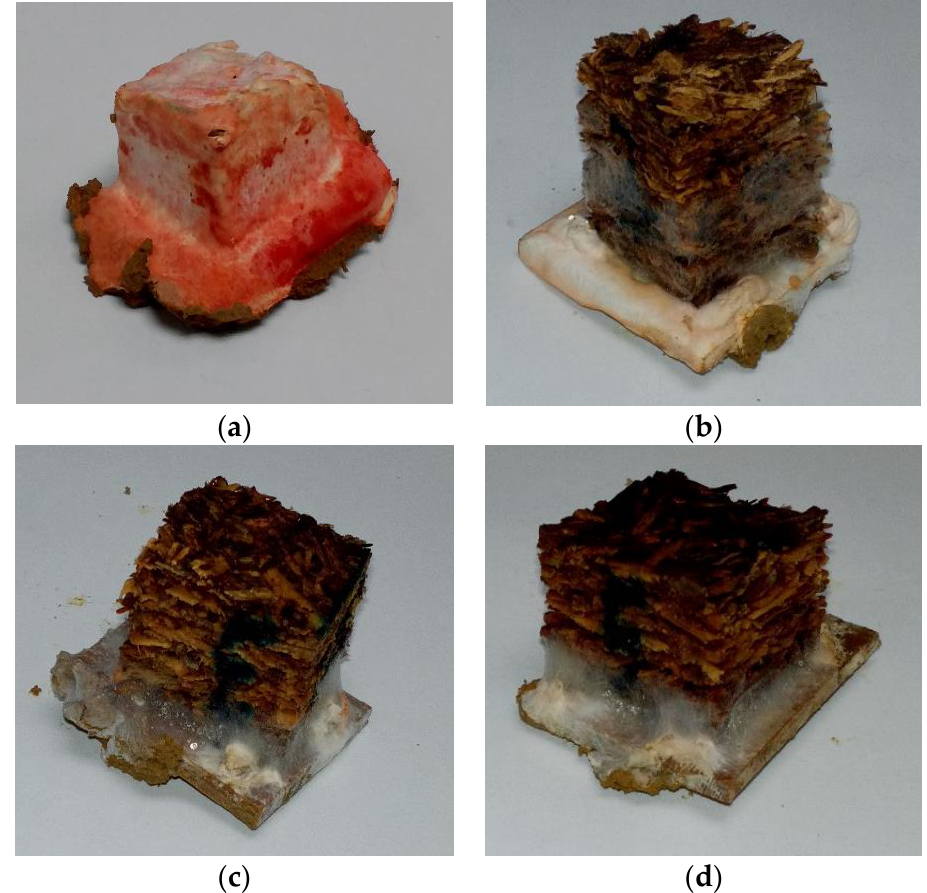
Figure 3. Visual appearance of particleboard (25 mm × 25 mm) after 16-week exposure to Pycnoporus sanguineus : ( a ) control *, ( b ) 10 wt% citric acid, ( c ) 15 wt% citric acid * and ( d ) 20 wt% citric acid. * Zhou et al. [17].